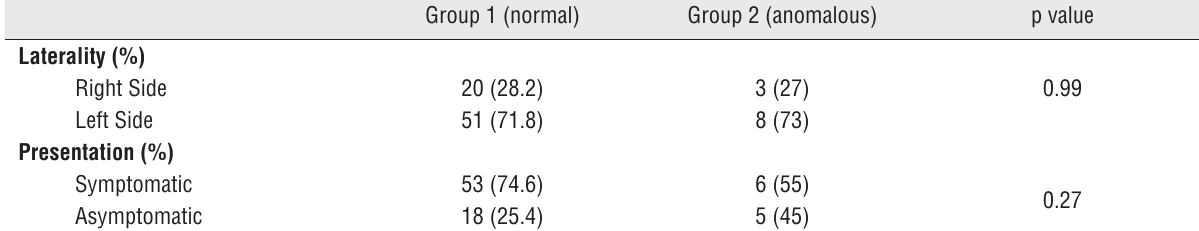
Table 1B - Clinical data.